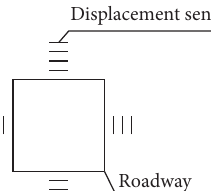
Figure 10: The schematic diagram of roadway monitoring spots’